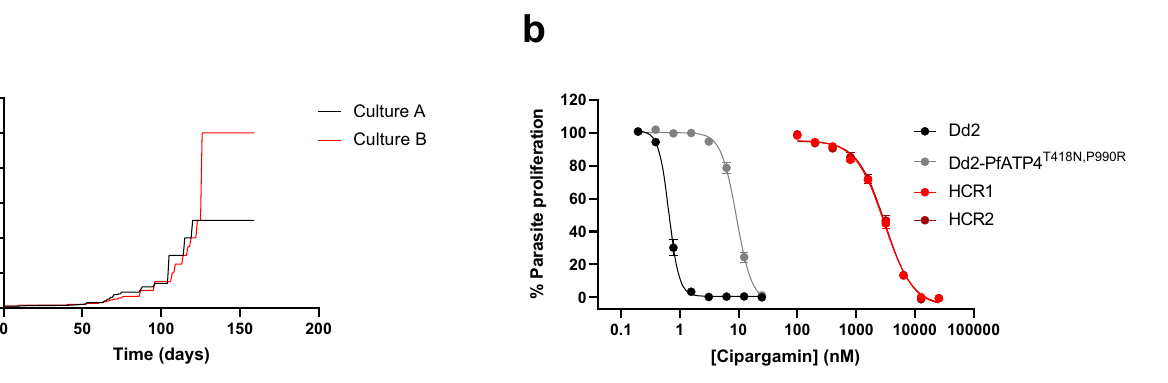
PfATP4 T418N,P990R parasites (grey circles), and highly cipargamin-resistant (HCR) parasites (clone #1 in red circles and clone #2 in dark red circles). The data shown are the mean (± SEM) from 16 independent experiments, each performed on dif- ferentdays.Alllinesweretested inparallel.Wherenotshown,errorbarsfallwithin the symbols. Source data are provided as a Source Data fi